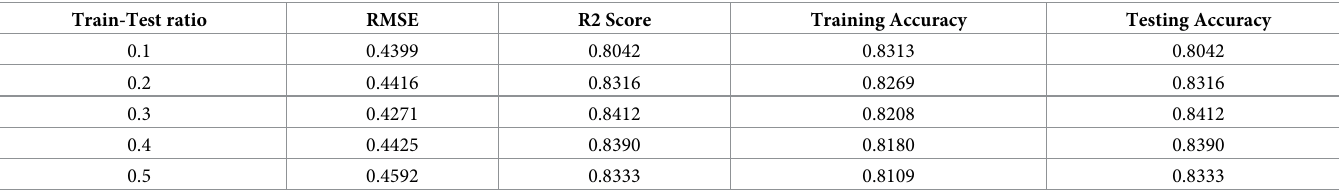
Table 6. Results of linear regression in terms of RMSE and